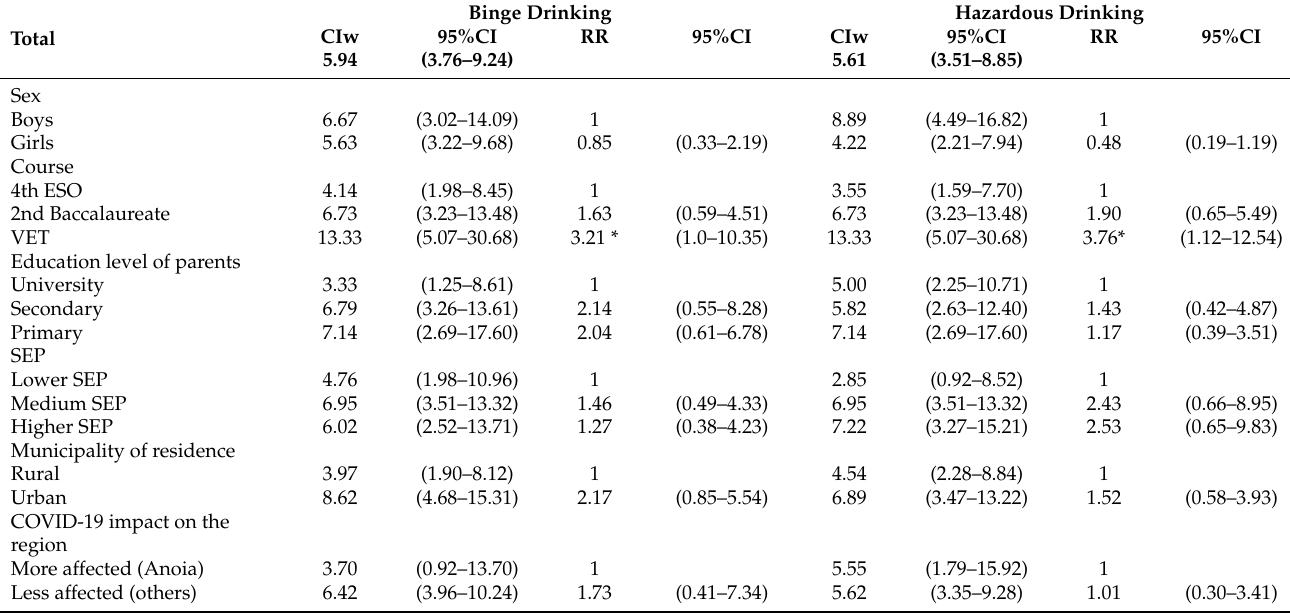
Table 4. Cumulative Incidence of worsening of binge drinking and hazardous consumption of alcohol, between groups during confinement and their associated factors in adolescents from Central